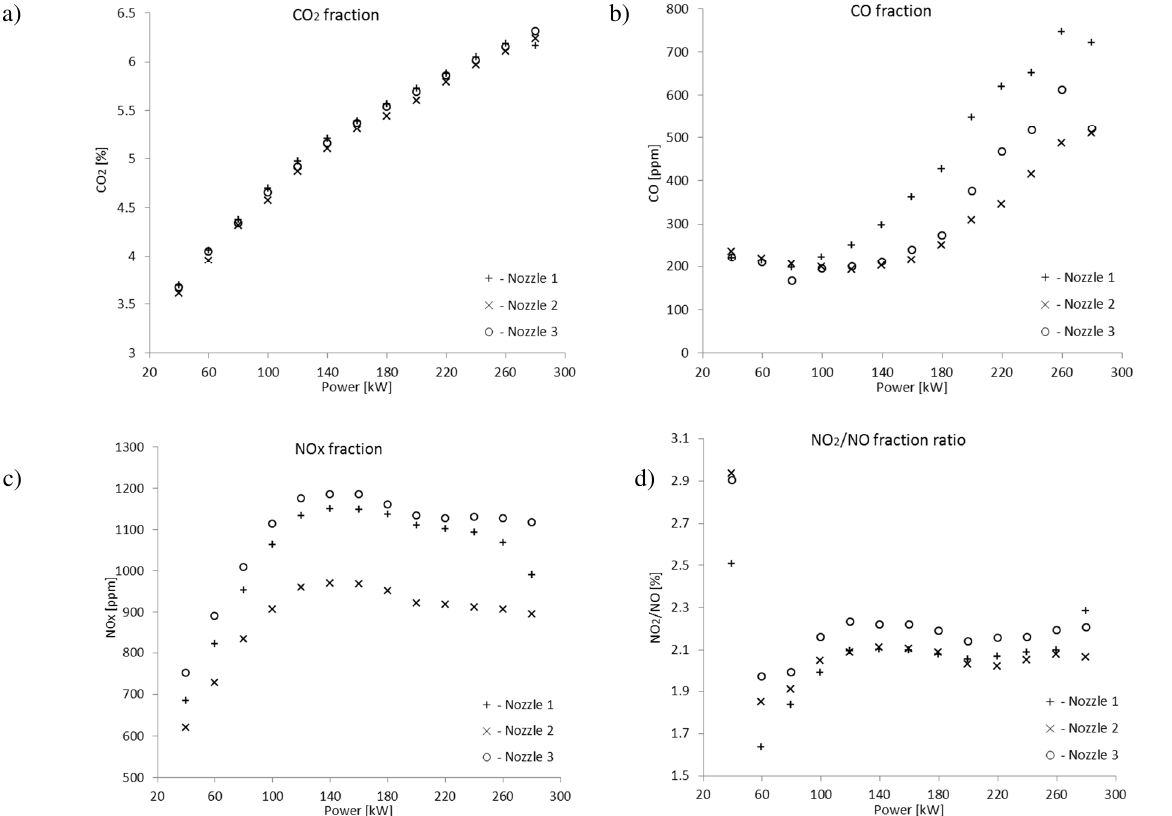
Fig. 4. Fractions of chosen chemical compounds in the exhaust gas